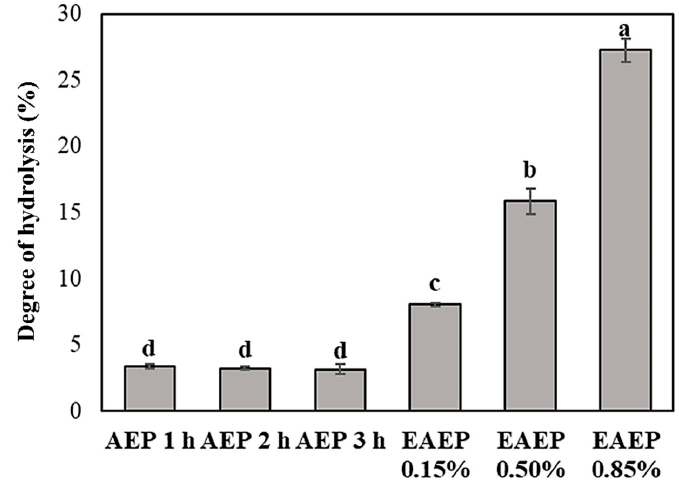
Figure 5. Effects of extraction conditions evaluated during the experimental validation of the AEP and EAEP on the degree of hydrolysis (%) of AEP and EAEP skim proteins. Data were analyzed by one-way ANOVA followed by Tukey’s post-hoc test. Different letters indicate significant difference between the samples at p < 0.05.